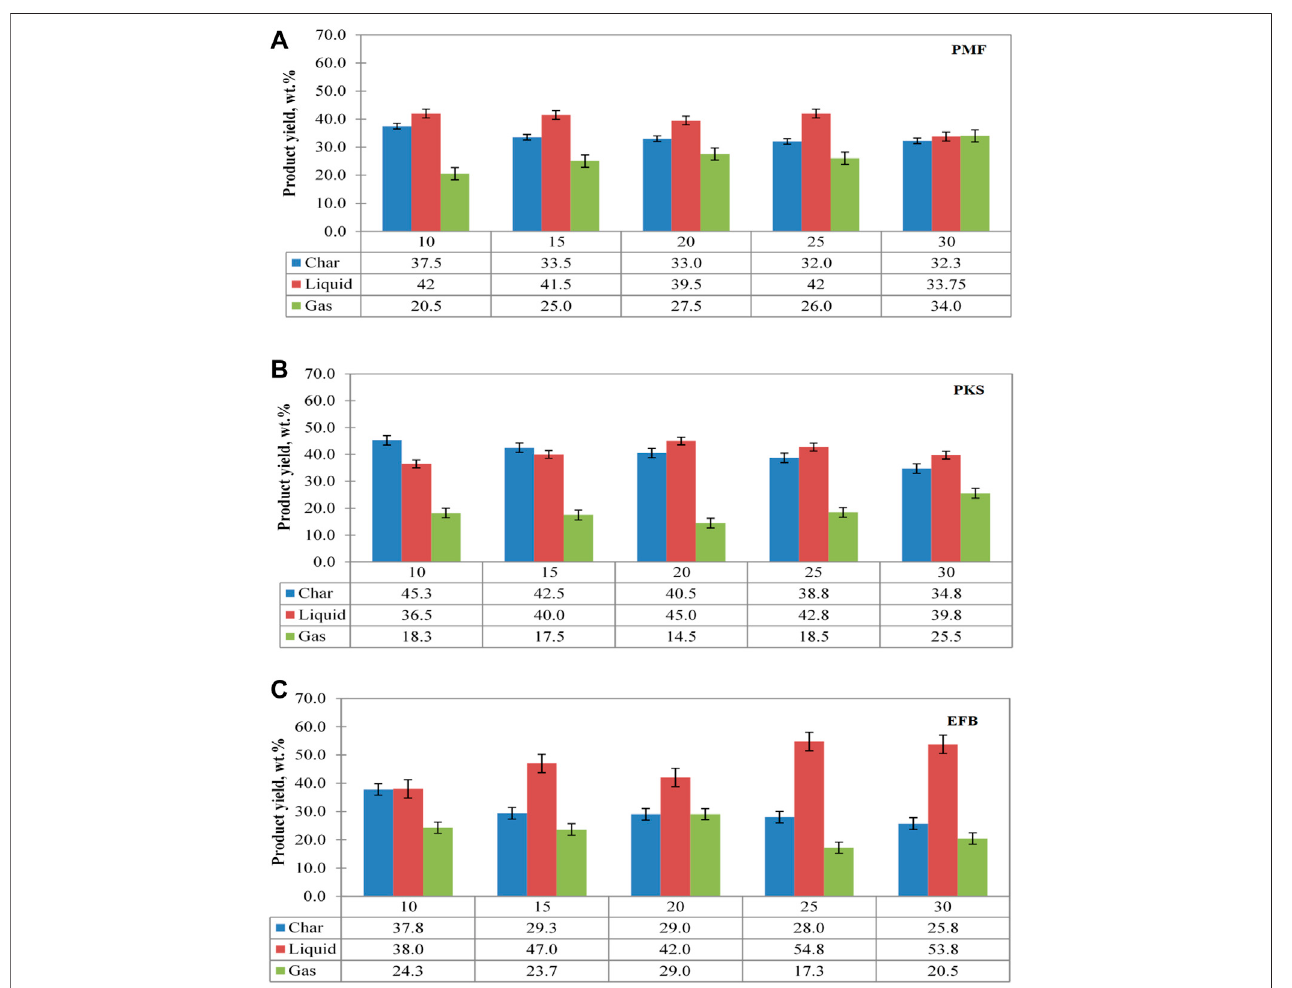
FIGURE 4 | Effect of exposure time on product distribution for (A) PMF, (B) PKS, and (C) EFB at 300 W.